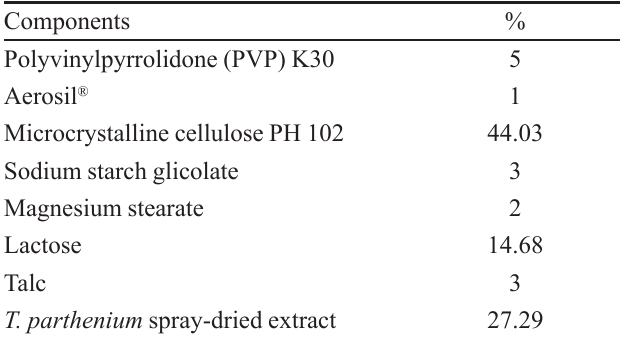
TABLE II - Composition of tablets containing feverfew spray- dried extract